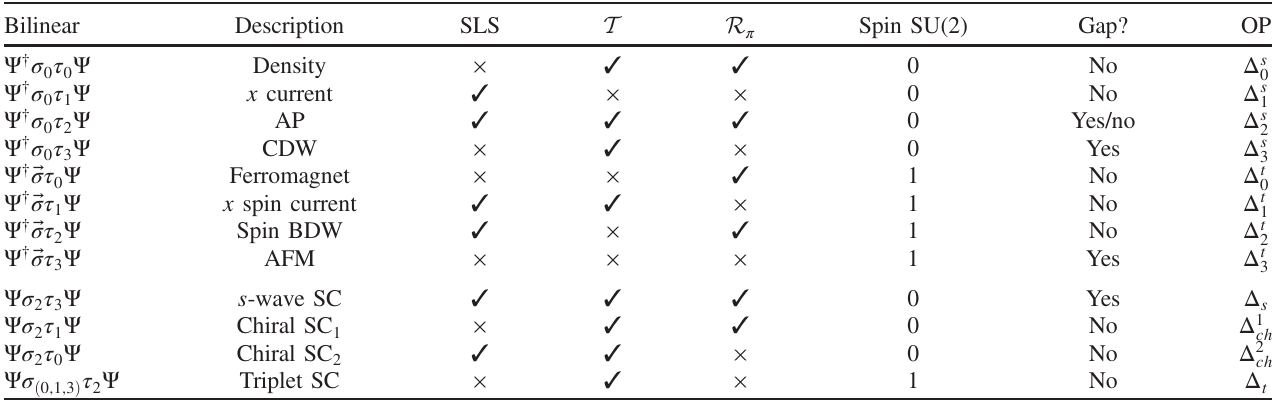
TABLE II. All possible local (momentum-independent or intra-unit-cell) order parameters in the particle-hole or excitonic channel (first eight rows) and particle-particle or superconducting channel (last four rows) and their transformation properties under various discrete and continuous symmetry operations, discussed in Sec. II B. Under spin SU(2), bilinears transform in either the singlet (0) or triplet (1) representations. Note that the anisotropy parameter (AP) preserves all microscopic symmetries and, respectively, gives rise to gapless and gapped spectra for Δ < 0 and Δ > 0 on the corresponding sides of the Dirac-semimetal to band-insulator transition. The second to last column shows whether the quasiparticle spectrum inside a given broken-symmetry phase is fully gapped or not. Notice that only three ordered phases, namely, the CDW, N´eel antiferromagnet (AFM), and s -wave SC, yield a fully gapped spectrum. These three orders are energetically most favored, at least within the framework of the weak coupling renormalization group analysis [see, for example, the phase diagram of the extended Hubbard model in Fig. 4(b)]. The last column labels the corresponding order-parameter (OP) source term (see also Sec. VII). The density, x current, and x spin current are included here for completeness, although these are not true order parameters. We